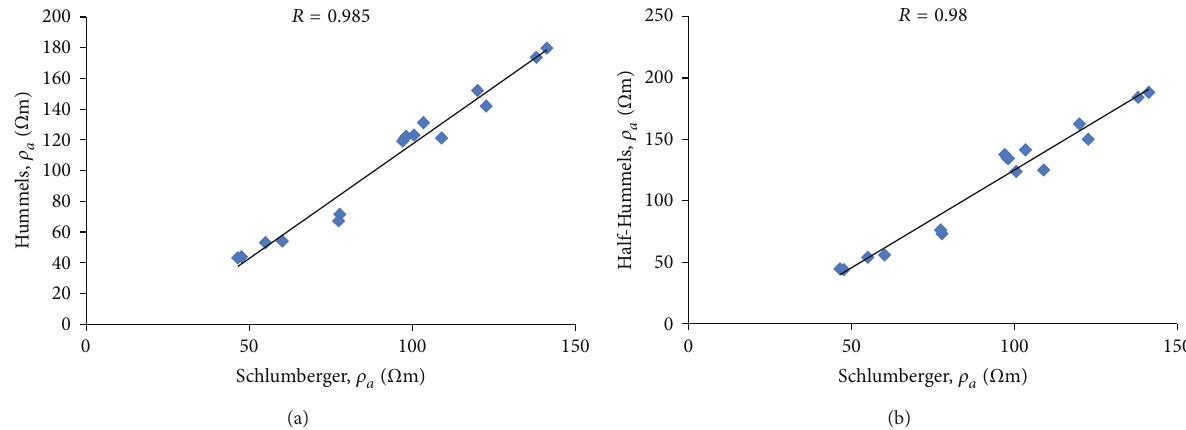
Figure 9: Statistical plot of apparent resistivity data for location 28 (quartz schist) (a) Hummel against conventional Schlumberger (VES) and (b) “Half-Hummel” against conventional Schlumberger